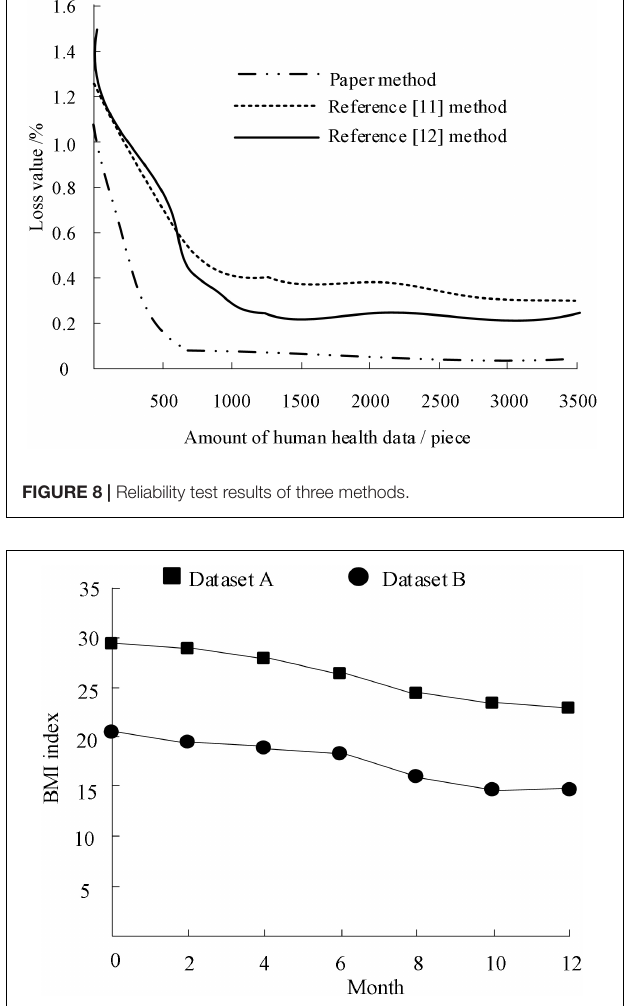
FIGURE 9 | Changes of mental health index of community residents and college students.